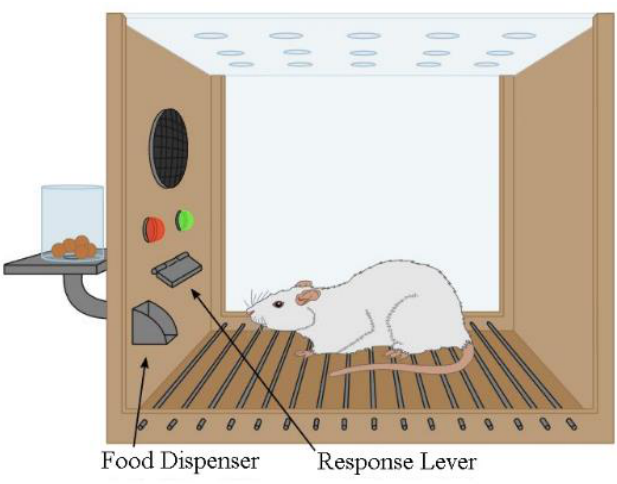
Figure 1. A version of a Skinner box for operant conditioning. The variable discussed is the rate at which a lever is pressed for food by the hungry animal when exposed to RFR.